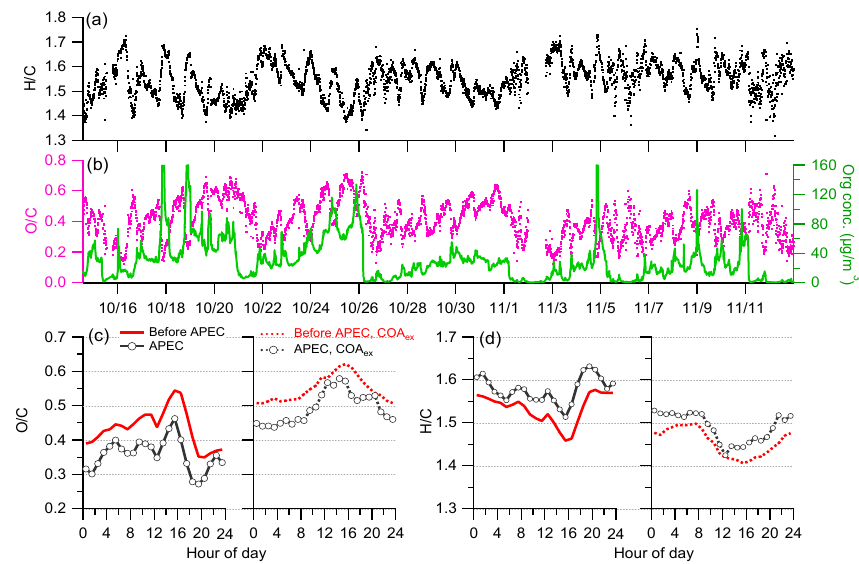
Figure 9. Time series of (a) H / C, (b) O / C, and organics, and diurnal variations of (c) O / C and (d) H / C. The dashed lines in (c) and (d) indicate the elemental ratios by excluding the contributions from cooking aerosols.